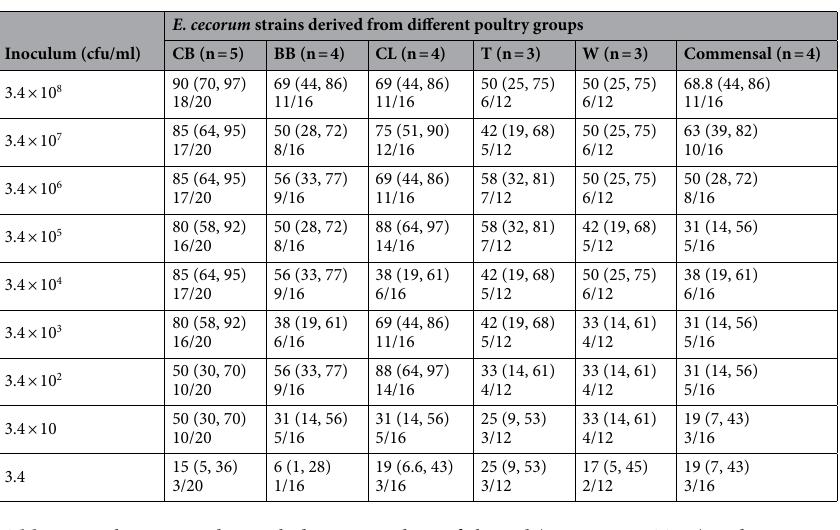
Table 1. Embryo mortality with decreasing dose of clinical (CB, BB, CL, T, W) and commensal Enterococcus cecorum strains from poultry. Results are presented as % mortality rate (with 95% CI) and the number of deaths / total embryos.